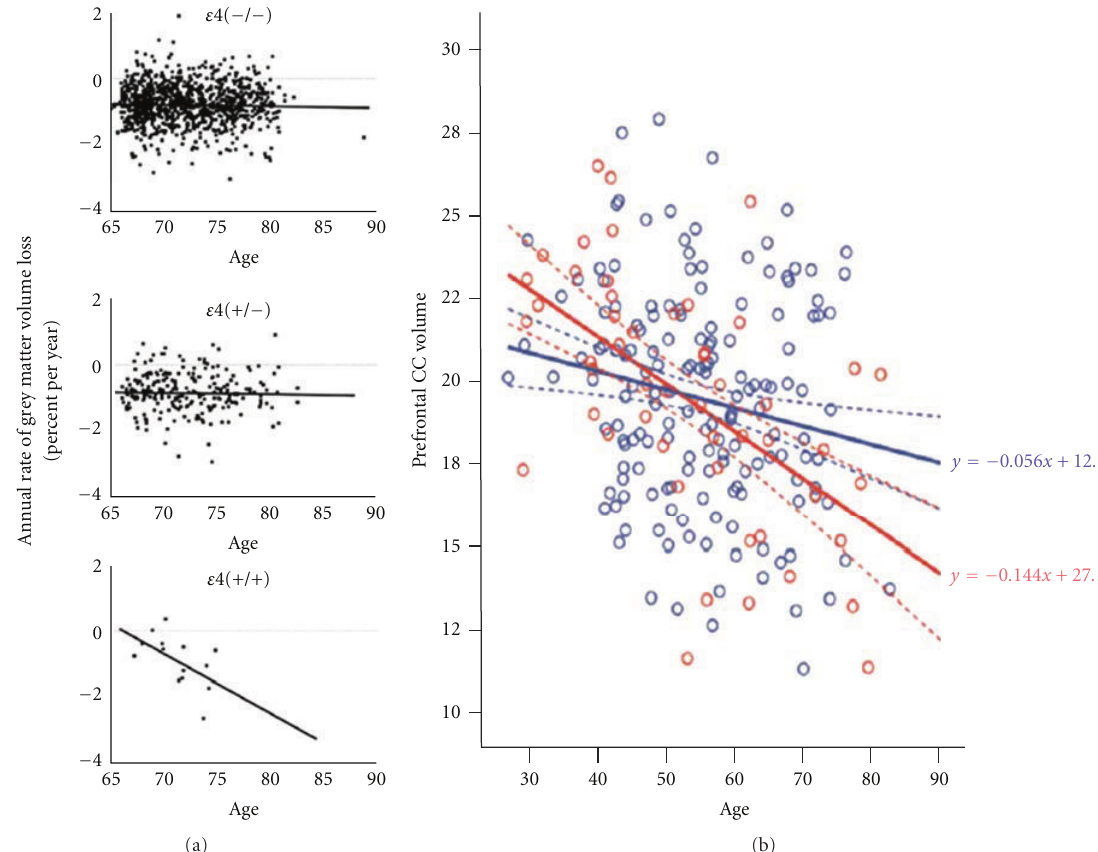
Figure 4: (a) Age e ff ect on the longitudinal followup of GMV for the three APOE ε 4 groups, illustrating the significant interaction between age and the APOE ε 4. ε 4 (–/–): noncarriers for the APOE ε 4 allele, and ε 4 (+/–): heterozygous for the APOE ε 4 allele, ε 4 (+/+): homozygous for the APOE ε 4 allele (adapted with permission from [30]). (b) Regression of the normalized volume of the prefrontal callosal subregion on age in APOE ε 4 carriers (red) and noncarriers (blue). Thick lines show linear regression lines and dotted lines 95% mean confidence intervals of the slope. Formulas denote regression lines. Normalization was done to total intracranial volume (adapted with permission from